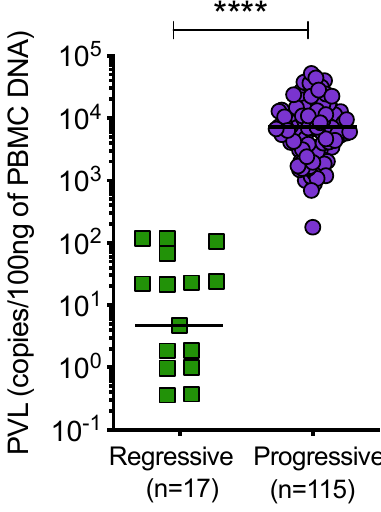
Figure 9. Proviral load (PVL), per 100 ng of PBMC DNA, was determined by qPCR. Cats with regressive infection showed significantly lower proviral loads compared to cats with progressive infection. Proviral load was not determined for 7 samples from cats with progressive infection. Statistical significance was determined using Mann–Whitney test ( p -value < 0.0001 ****).